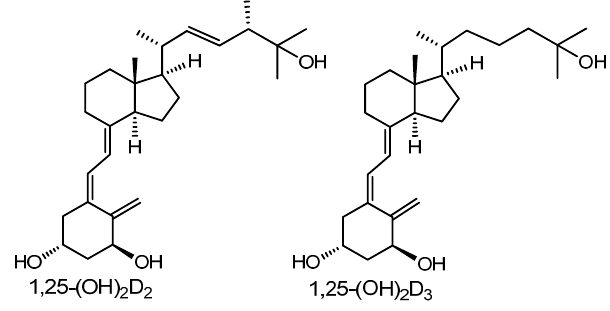
Figure 1. Structures of 1,25D 2 and 1,25D 3 .